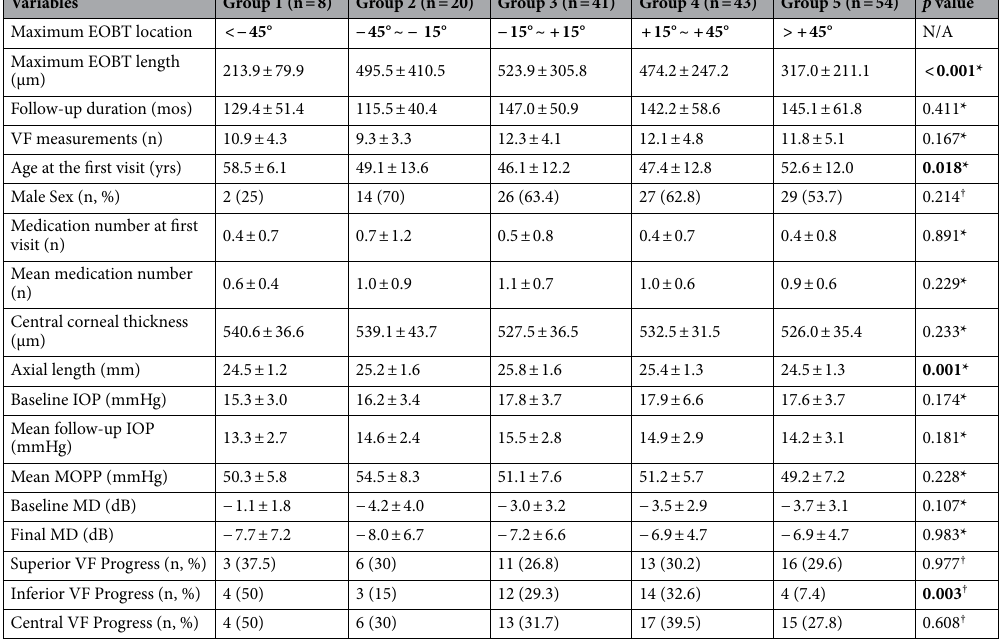
Table 2. Comparisons of variables among groups divided by the location of maximum externally oblique border tissue. EOBT externally oblique border tissue, IOP intraocular pressure, MD mean deviation, MOPP mean ocular perfusion pressure, VF visual field. Data are presented as the means ± standard deviations unless otherwise indicated. *Kruskal–Wallis test. † Fisher’s Exact